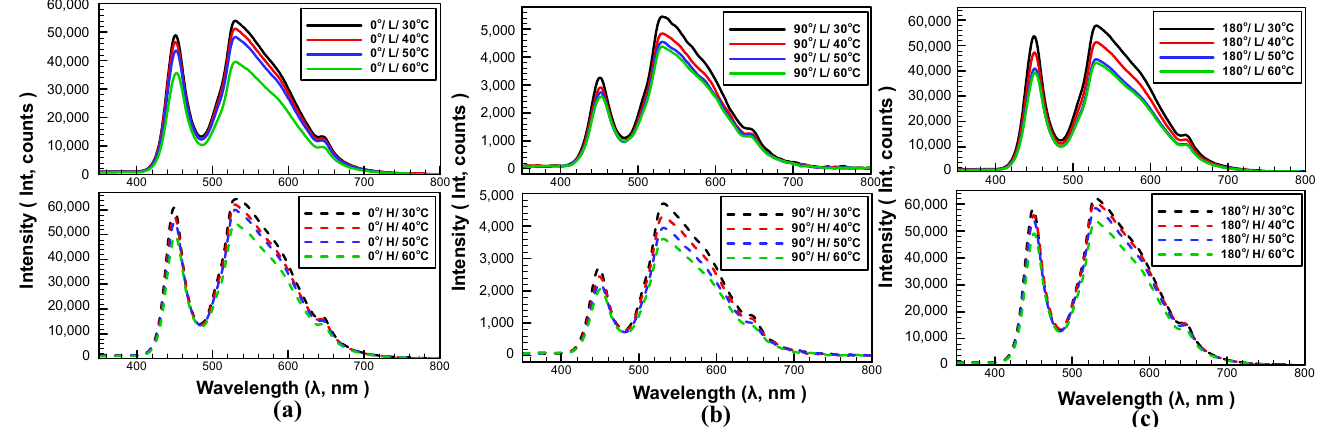
◦ , ( b ) 90 ◦ , and ( c ) 180 ◦ . Figure 4. Spectral measurement results of the LED lamp: ( a ) 0°, ( b ) 90°, and ( c ) 180°. Figure 4. Spectral measurement results of the LED lamp: ( a ) 0 To evaluate the effect of the temperature on relative spectral distribution, the data on each curve in Figure 4 are divided by the maximum value on that curve and multiplied by 100 to form Figure 5. Figure 5 indicates all the normalized spectral distributions of different T a almost coincided, which means that the temperature had little effect on the